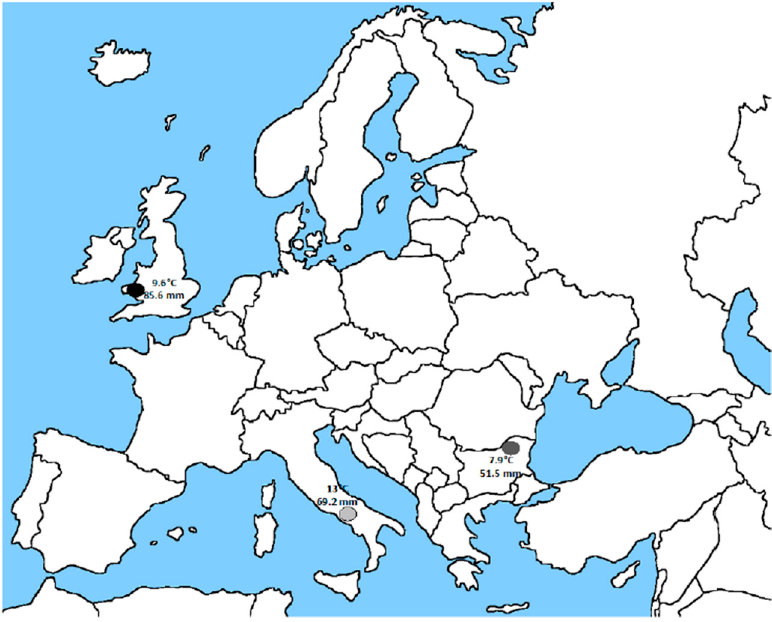
Figure 2. Sites of sampling of the selected L. corniculatus cvs. Light grey oval, Canetra cv; dark grey oval Leo cv; Black oval, Targovishte 1 cv. Numbers indicate annual average temperature and rainfall of the sampling sites.